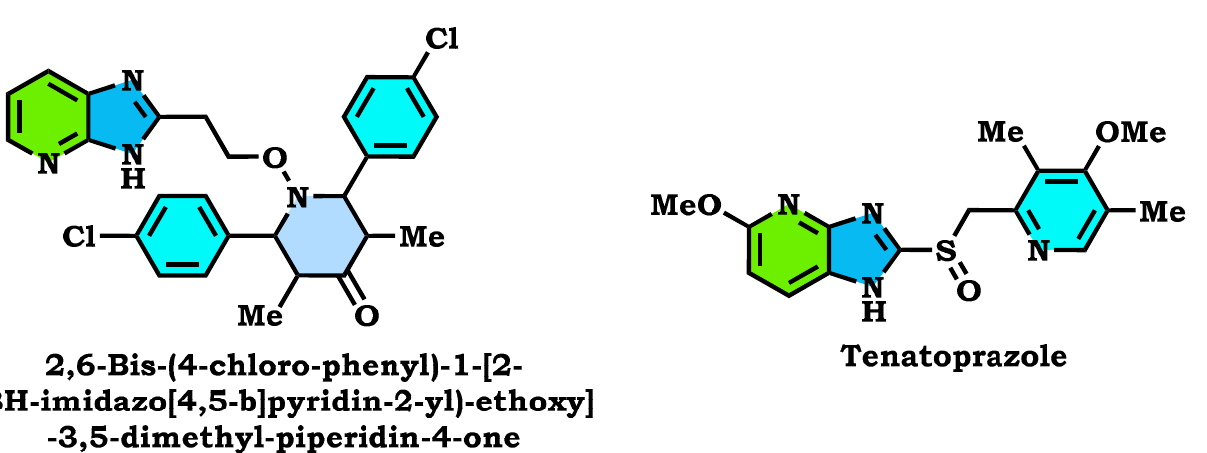
Figure 1. Structures of some drugs containing the imidazo[4,5-b]pyridine